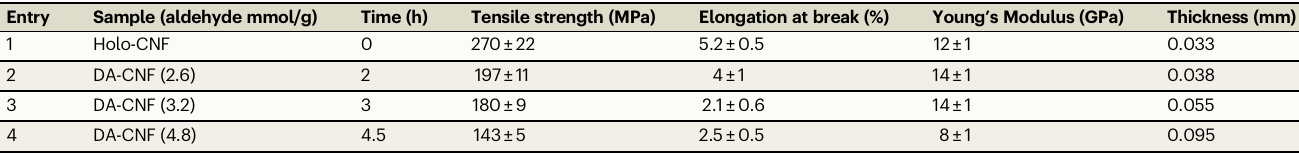
Table 1 | Static mechanical properties of CNF and DA-CNF fi lms with different degrees of oxidation obtained upon different reaction times Entry Sample (aldehyde mmol/g) Time (h) Tensile strength (MPa) Elongation at break (%) Young ’ s Modulus (GPa)